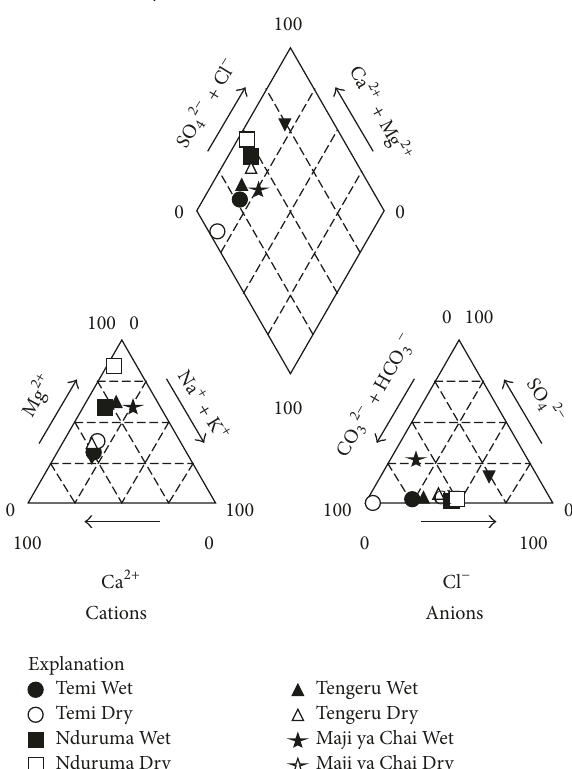
Figure 3: Piper diagrams for distribution of major cations and anions in the four